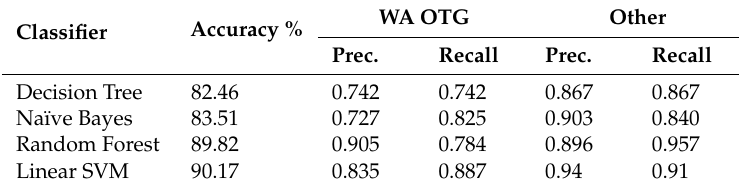
Table 7. Comparison of results achieved with different classifiers for the ADon dataset.